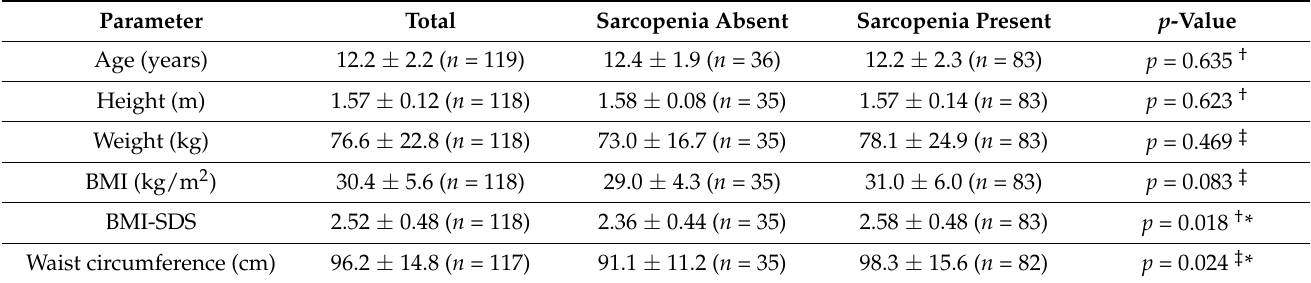
Table 1. Anthropometric data for the whole group and by the presence of sarcopenia. Parameter Total Sarcopenia Absent Sarcopenia Present p